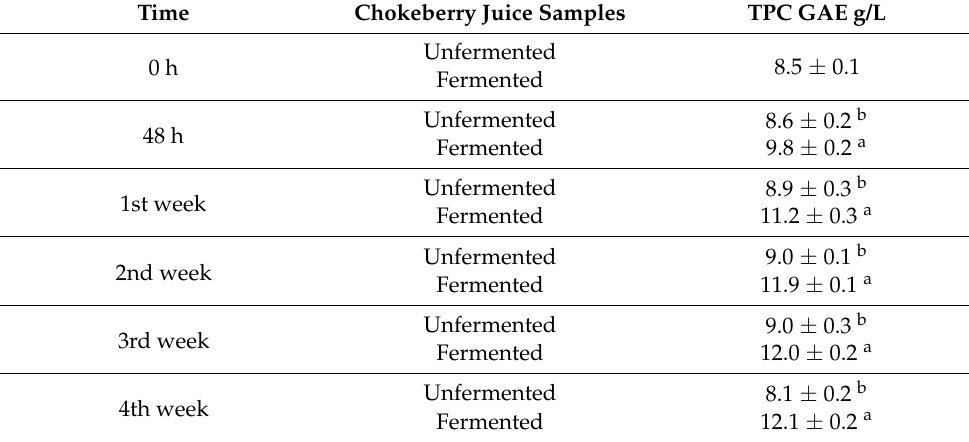
Table 3. Total phenolic content (TPC) of the chokeberry juice with 40.3 g/L initial sugar concentration after fermentation (30 ◦ C for 48 h) and during storage (4 ◦ C for 4 weeks). Time Chokeberry Juice Samples TPC GAE g/L 0